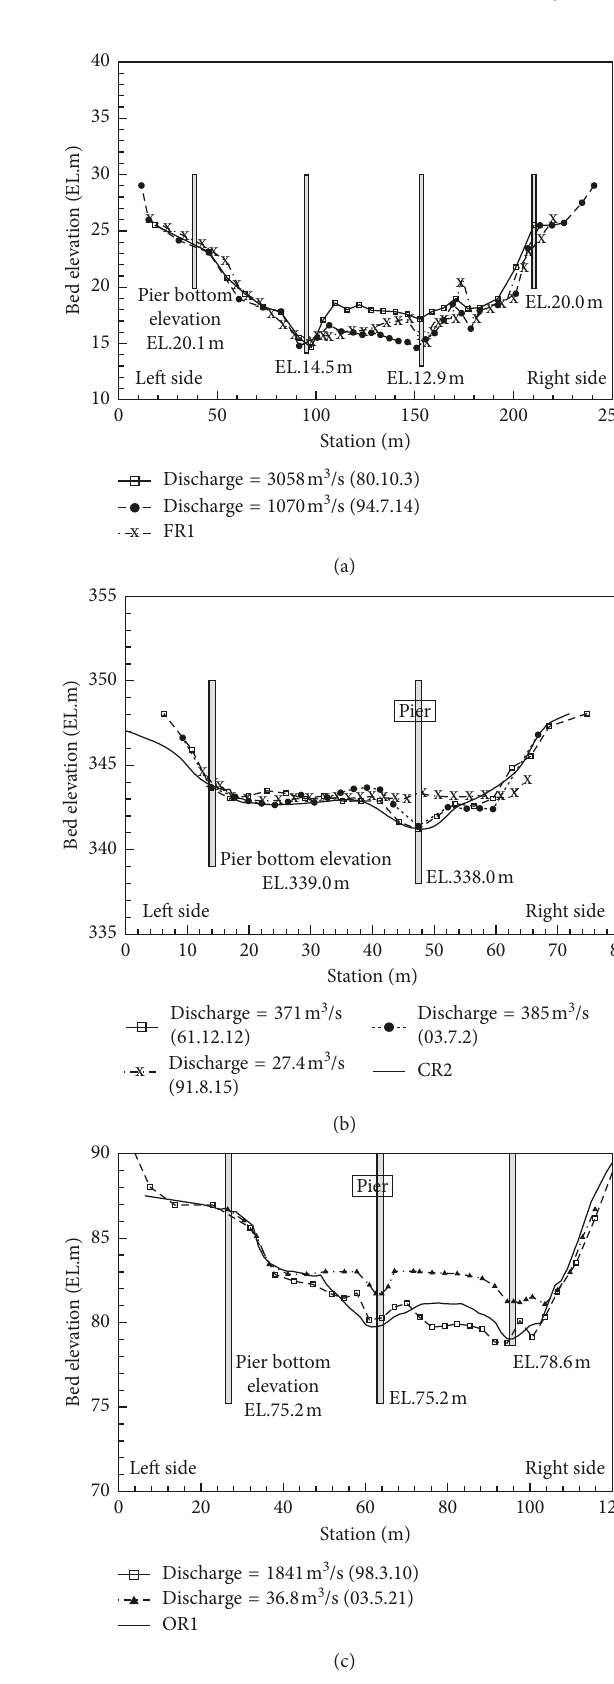
Figure 7: Cross section comparison between laboratory and field measurements for (a) FR1, (b) CR2, and (c)